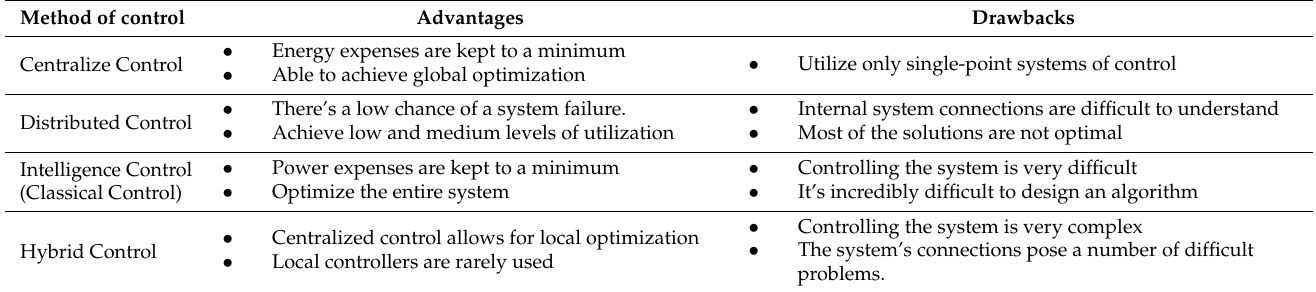
Table 10 highlights the key categories of control, as well as their benefits and drawbacks. Table 10. A comparison of the various control techniques [19,26,96,97]. Table 10. A comparison of the various control techniques [19,26,96,97]. Table 10. A comparison of the various control techniques [19,26,96,97].